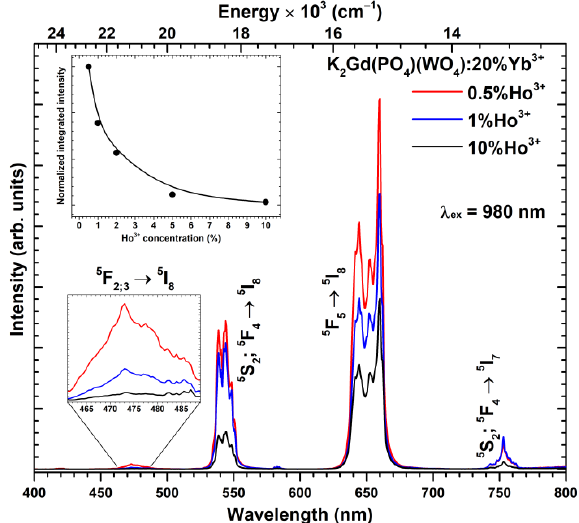
Figure 5. Up-conversion emission spectra of K 2 Gd(PO 4 )(WO 4 ) as a function of Ho 3+ concentration, under the 980 nm excitation. The inset graph shows Ho 3+ concentration-dependent normalized integrated emission.